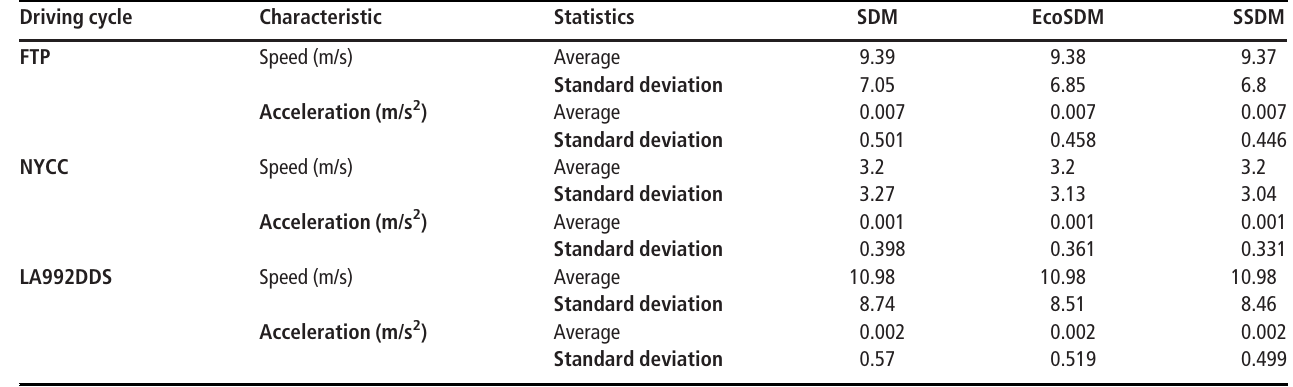
Table 1 Performance of different control strategies Driving cycle